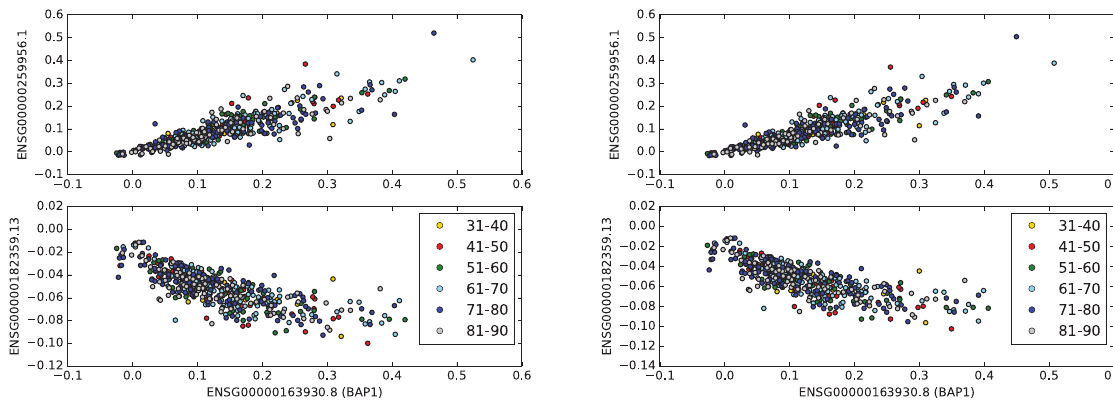
Fig 4. Highly correlated genes with BAP1 in COAD. The top sub-figure shows the scatter plot of the values of BAP1 and the gene, which has the maximum positive correlation with BAP1 in the entire colon cancer data set. The bottom sub-figure shows the scatter plot of the values of BAP1 and the gene, which has the maximum negative correlation with BAP1 in all patients with colon adenocarcinoma. The right panel shows the exact same scatter plot as the left panel using